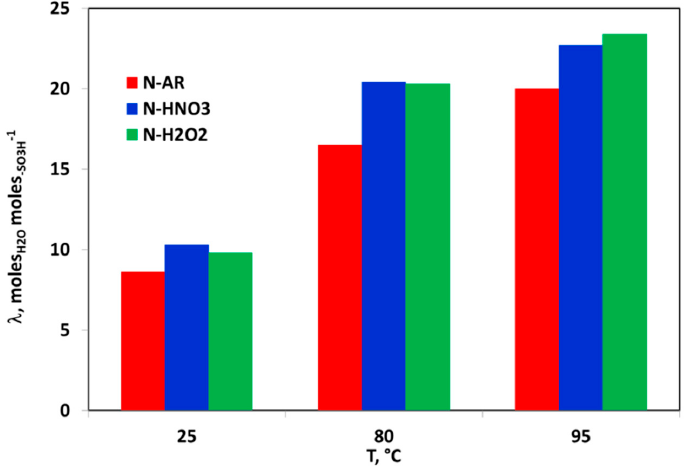
Figure 3. Number of water moles for sulfonic group ( λ ) as a function of temperature for N-AR (red bar), N-HNO3 (blue bar) and N-H2O2 (green bar).